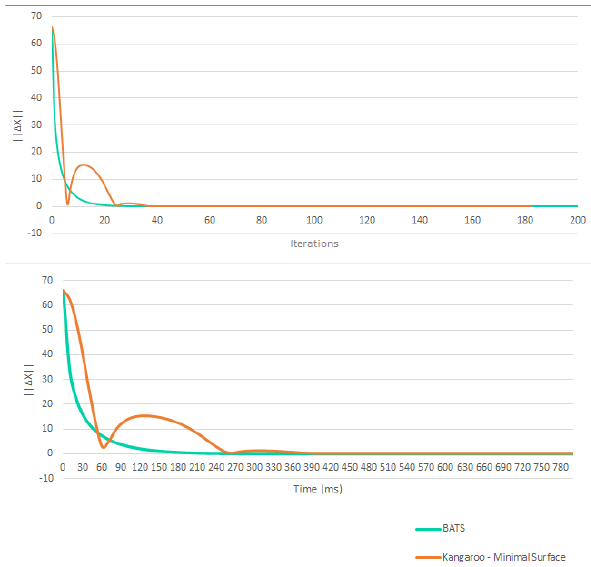
Figure 19: Iteration and time comparison for h = 1.30 r .